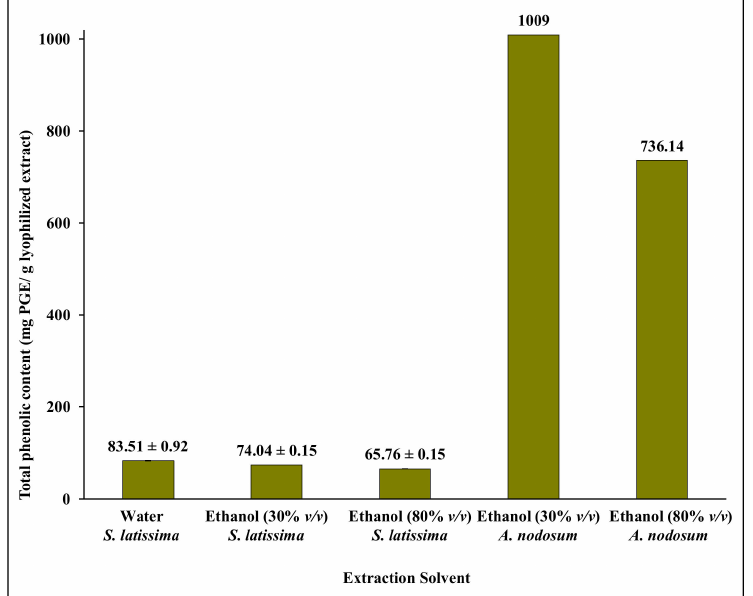
Figure 2. Total phenolic content (TPC) of lyophilized purified extracts (1 g/L) from solvent extraction of S. latissima and A. nodosum after two step purifications. Data for S. latissima are mean ± SD corresponding to two experimental replicates and data for A. nodosum are corresponding to single